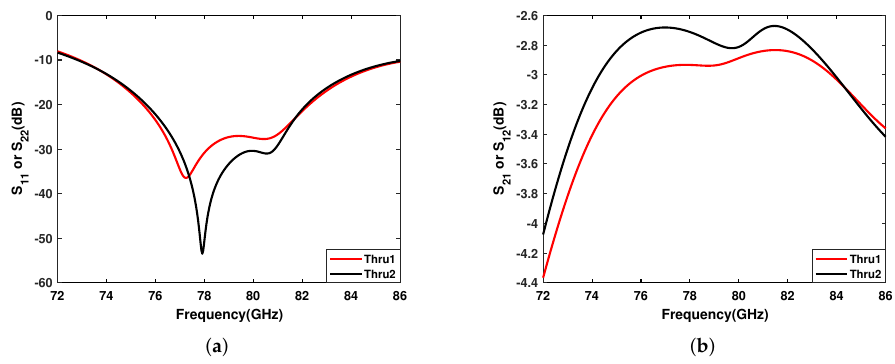
Figure 16. S parameters of the designed thru structure. ( a ) S 11 or S 22 , ( b ) S 21 or S 12 .